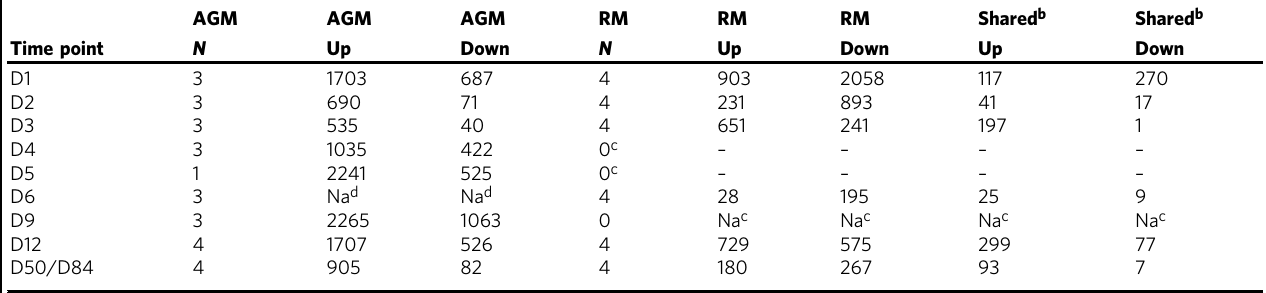
Table 1 Study overview